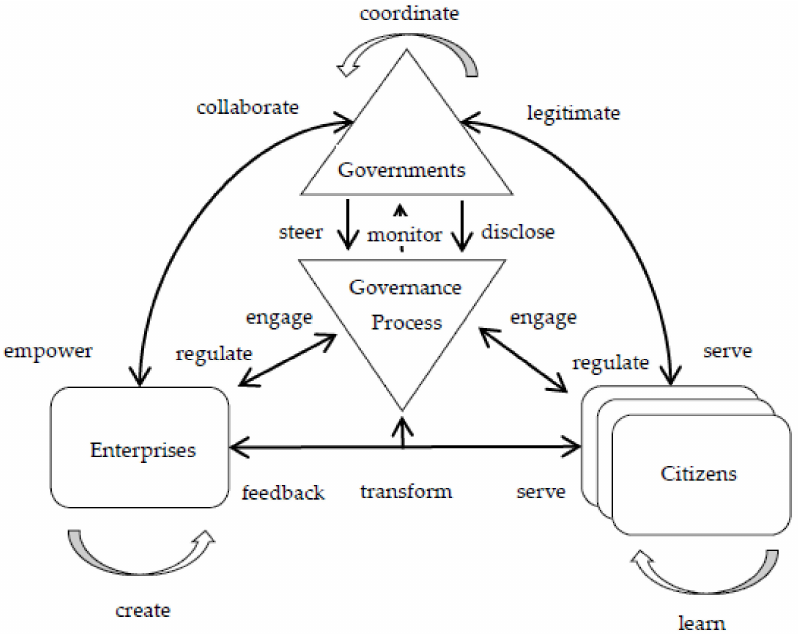
Figure 1. Holistic governance framework for sustainable public